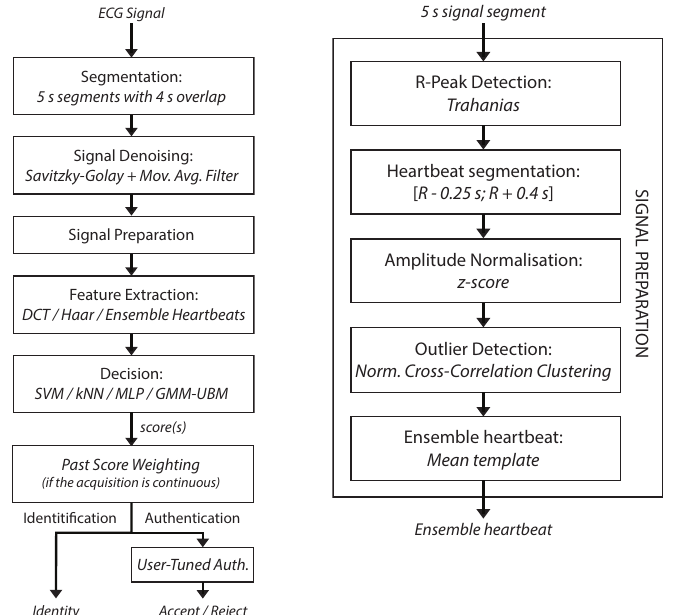
Figure 2. Overview of the proposed method, from acquisition to recognition ( left ), and the detailed process of the signal preparation block ( right